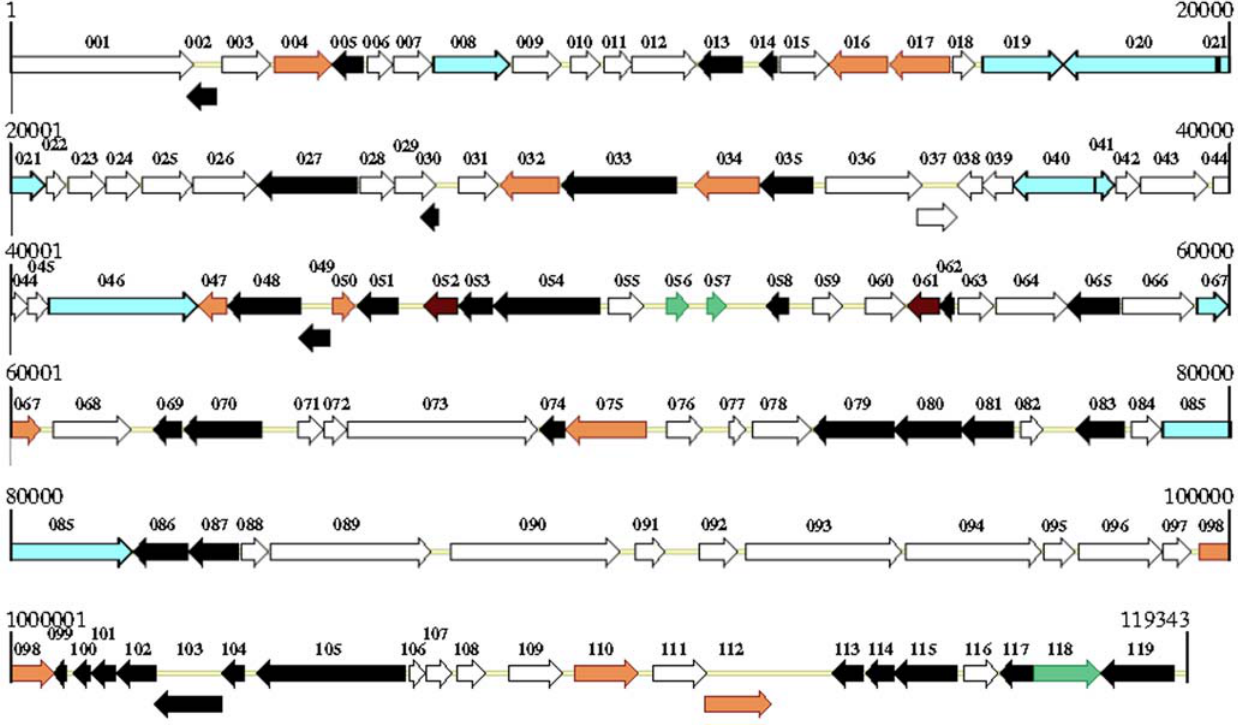
Figure 1. Schematic illustration of the organization of the Diadromuspulchellusascovirus4a (DpAV4a) genome. Predicted ORFs are indicated by their location, orientation, and putative size. White arrows represent ORFs on the forward strand, whereas black arrows identify those on the reverse strand. ORFs corresponding to members of repeated protein families are light orange for the BRO-like proteins, green for the metallo- hydrolases, and purple for the ABC-type transport system permease. ORFs encoding peptides present in TnAV2a and SfAV1a virions are light blue. The DpAV4a genomic map was constructed using Vector NTI (Invitrogene).